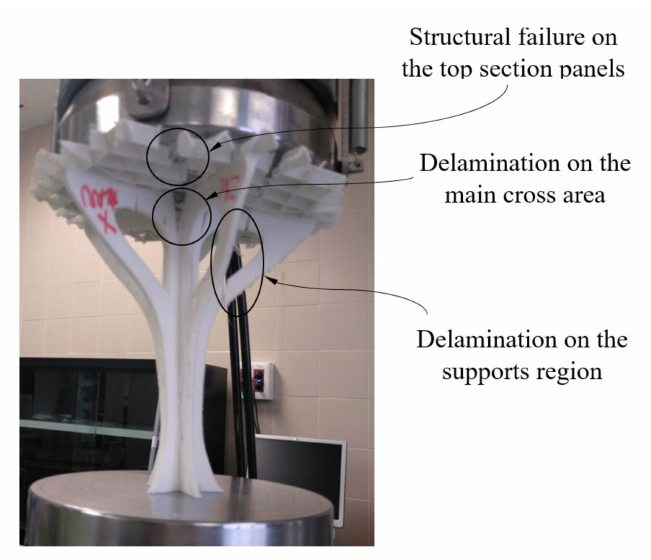
Figure 13. Fracture of the X–Y-axis printed element under